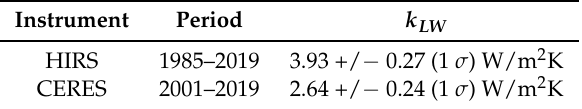
Figure 1. Outgoing Longwave Radiation plus greenhouse gas radiative forcing as a function of the Earth’s temperature increase compared to pre-industrial conditions. Purple crosses: HIRS OLR measurements for the period 1985–2019. Green line: linear fit to HIRS OLR. Blue stars: CERES OLR measurements for the period 2001–2019. Orange line: linear fit to CERES OLR. Table 1. Empirical determination of the longwave climate feedback